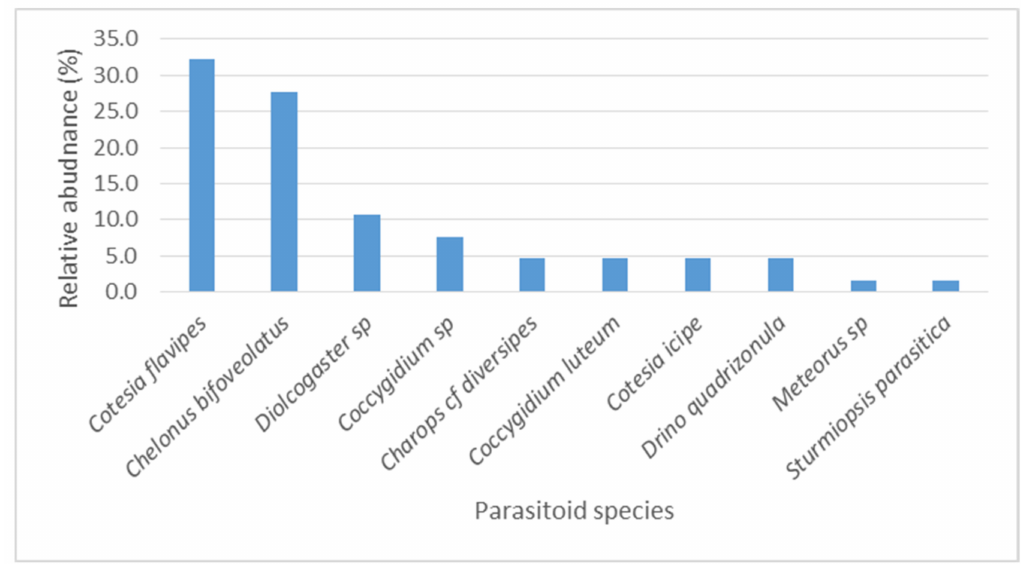
Figure 4. Relative abundance of parasitoid species of Spodoptera frugiperda larvae in 2019 across all surveyed districts in